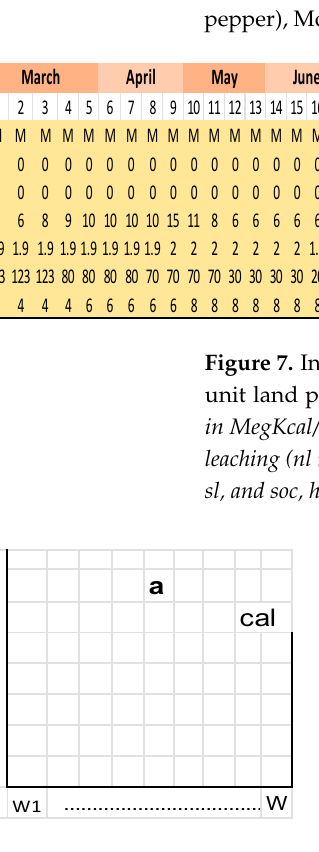
Figure 8. Input parameter characteristics used in the model for the alternative crop succession: ( a ) food calorie (ca), ( b ) crop income(ci), ( c ) crop cost (cc), ( d ) nitrate leaching (nl), ( e ) soil loss (sl), ( f ) soil carbon sequestration (soc), ( g ) crop water requirement (cwr). 2.3. Methods The Gebre mathematical land and water allocation optimization model was used to simulate the Omo-Gibe river basin land and water allocation to meet water, food, en- ergy, and environmental conservation under climate services through climate-smart land use planning. This model is a linear programming optimization model which has multiple objectives and constraint functions (Table 1). It is conceived to optimize the allocation of